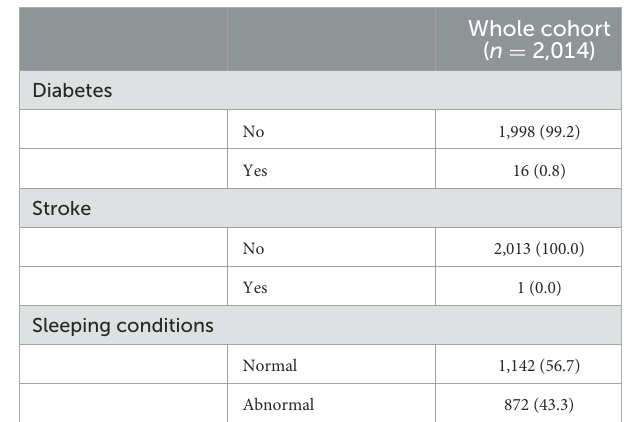
TABLE 1 Basic information for clinical nurses ( n = 2,014).